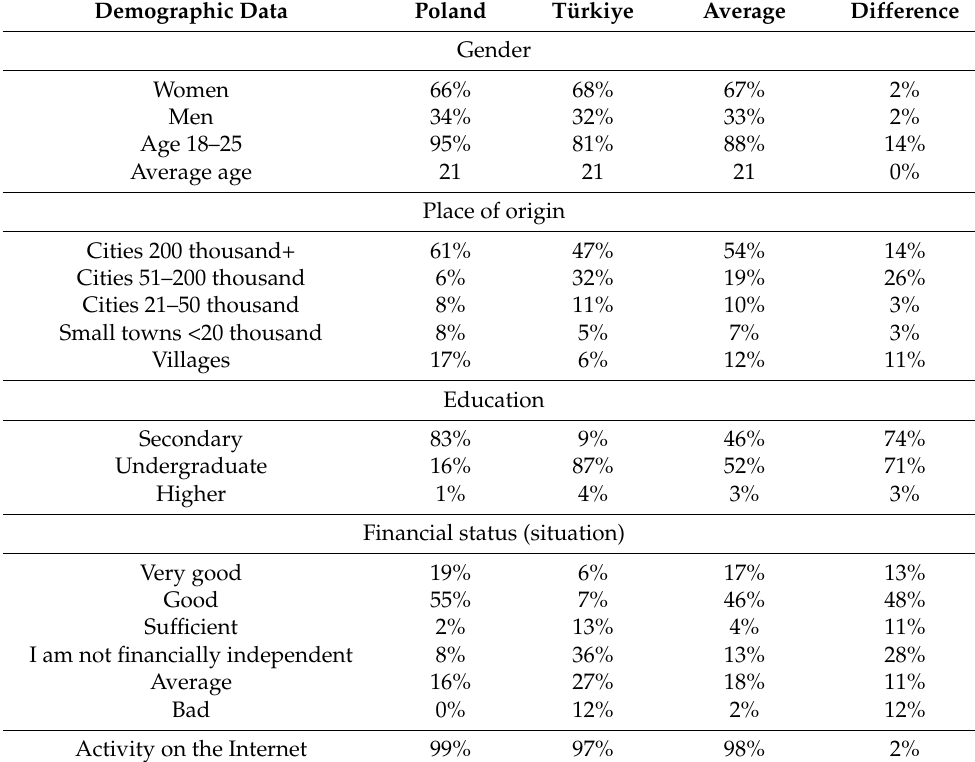
Table 1. Selected sample